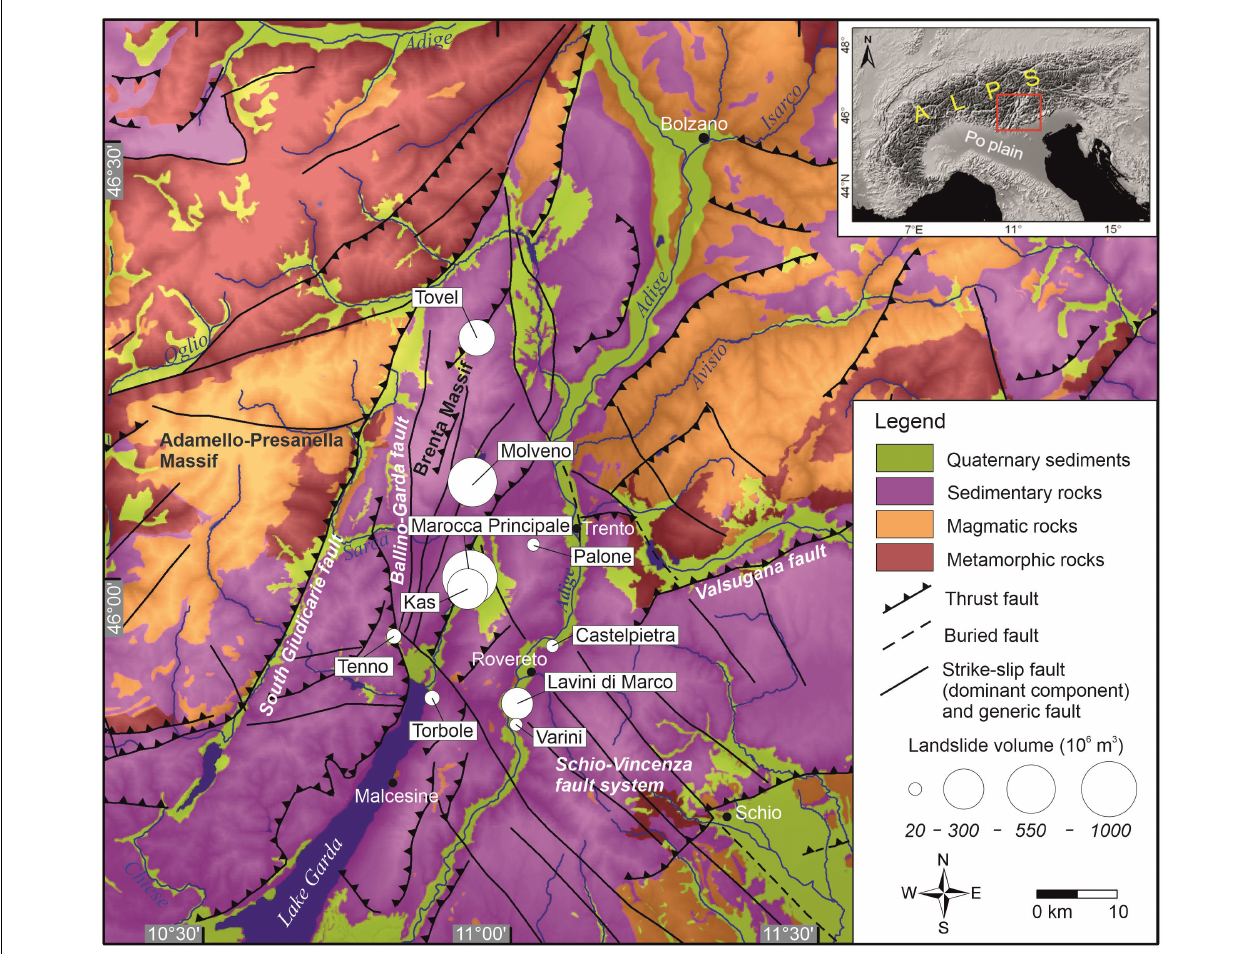
FIGURE 1 | Geological map showing rock avalanches in the province of Trento and their approximate size. Geologic data from the Geological Survey of Trento, CARG project database. Map modified from Ivy-Ochs et al. (2017a). The studied landslide is labeled as